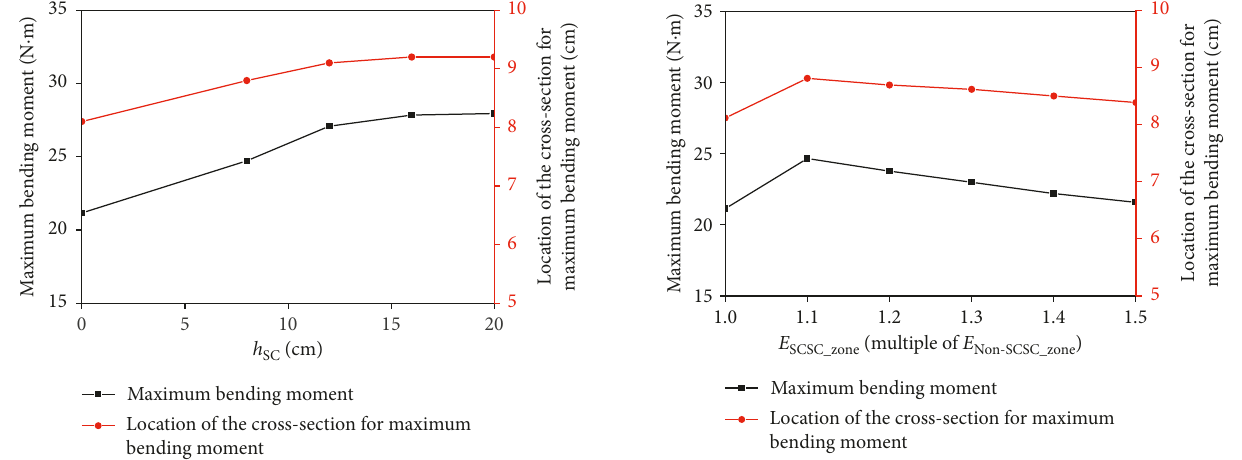
Figure 17: Change rule of the maximum bending moment of the CCFSTP and the location of the cross-section of the CCFSTP.